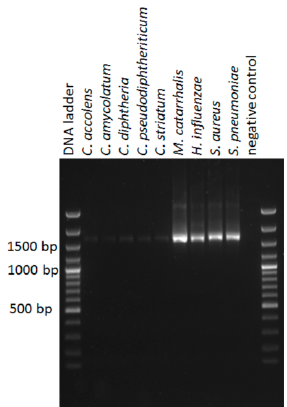
Figure 3. Agarose gel with 16S rRNA gene amplicons. Total DNA was isolated from pure bacterial cultures in a similar manner as the isolation of DNA from the nasal swab samples; the DNA concentration was determined by picogreen and a PCR was performed as described for nanopore sequencing using equal amounts of template DNA, with the exception that 30 PCR cycli instead of 25 cycli were used.